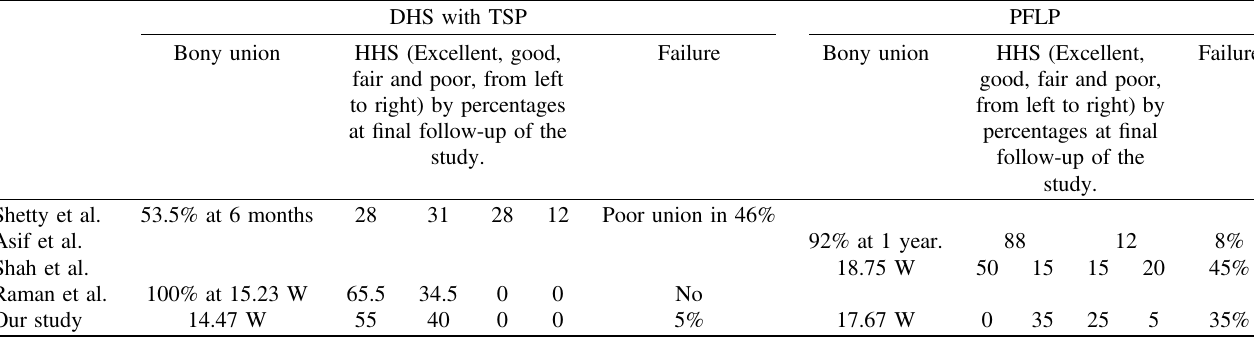
Table 3. Comparison between our study and other relevant studies. DHS with TSP PFLP Failure Failure Bony union HHS (Excellent, Bony union HHS (Excellent, good, good, fair and poor, fair and poor, from left from left to right) by to right) by percentages percentages at fi nal at fi nal follow-up of the follow-up of the study. study. 92% at 1 year. Shah et al. 18.75 W